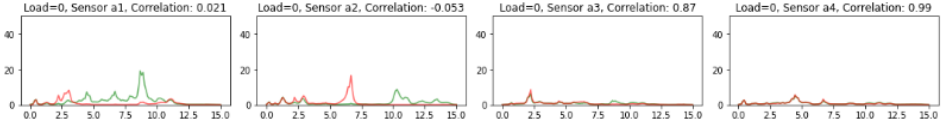
Figure 8. Power-spectral-density graph of all four sensors at load 0.